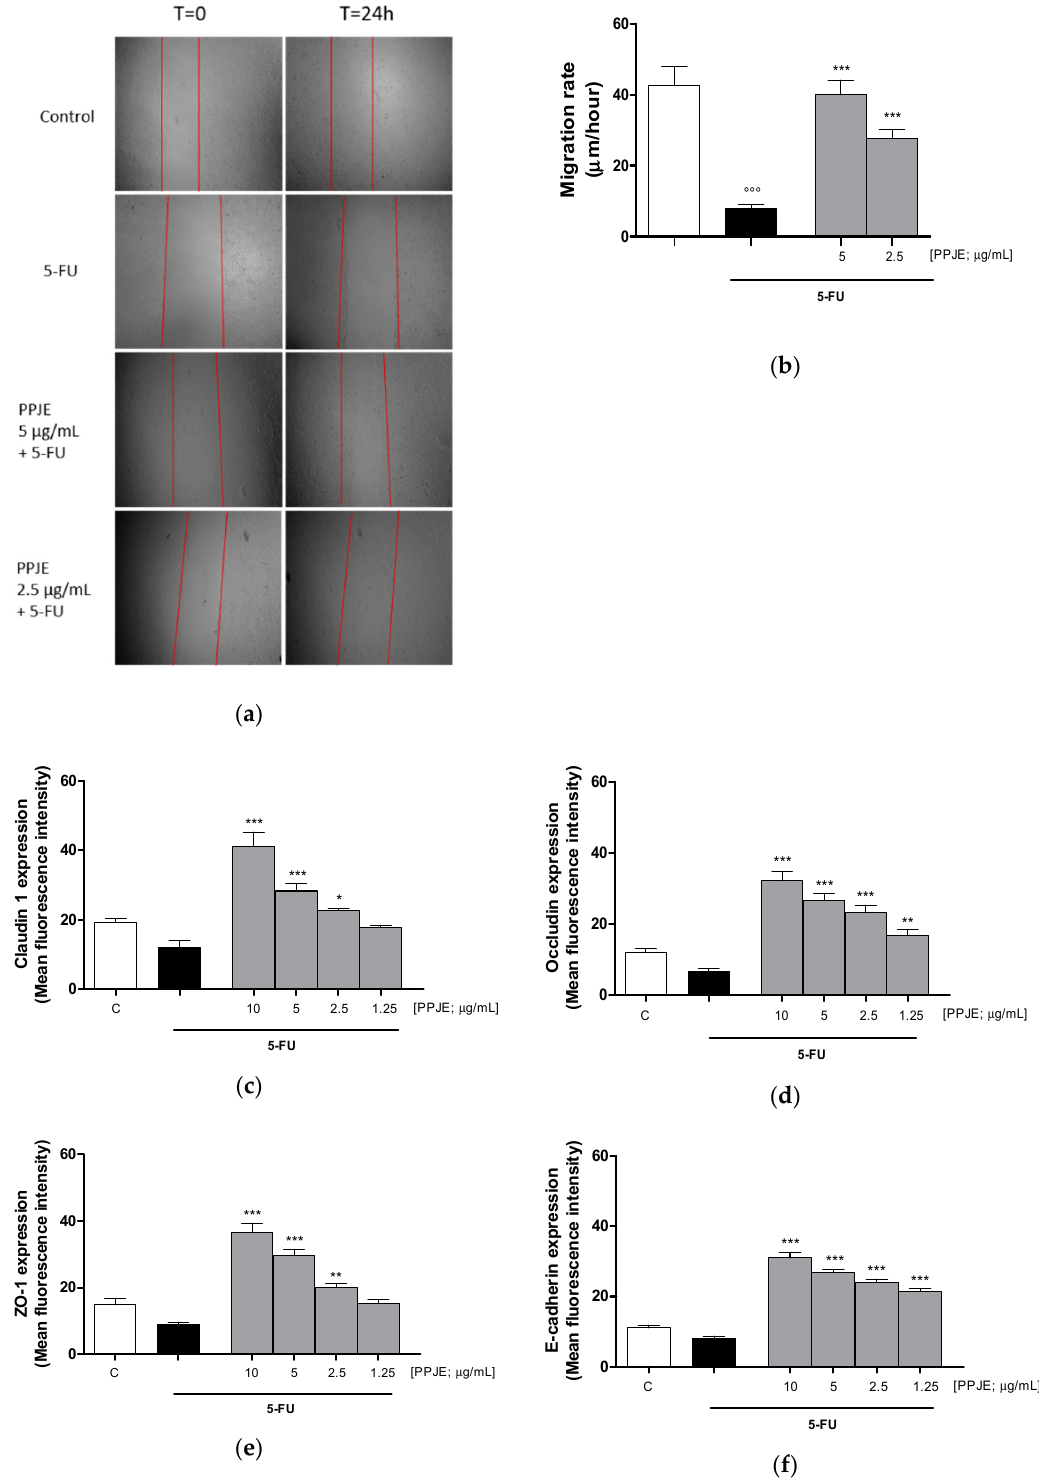
Figure 7. E ff ect of PPJE (5–2.5 µ g / mL) on wound repair after a mechanical scratch in IEC-6 treated with 5-FU (10 µ g / mL); Bar = 150 µ m ( a ), and the quantitative analysis expressed as IEC-6 migration rate after 24 h ( b ). Effect of PPJE (10–1.25 μ g/mL) in increasing Claudin-1 ( c ), Occludin ( d ), ZO-1 ( e ) and E-cadherin ( f ) expression, detected by flow cytometry, on 5-FU-treated IEC-6. Values are expressed as migration rate ( μ m/hour) or mean fluorescence intensity. C denotes control group. ***, ** and * denote respectively p < 0.001, p < 0.01 and p < 0.05 vs. 5-FU; °°° denotes p < 0.001 vs. C.